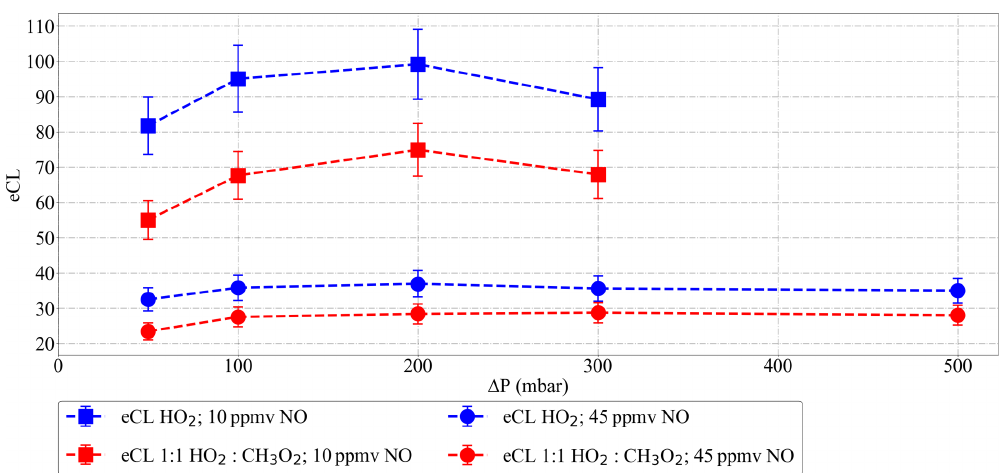
Figure 12. Dependency of eCL on (cid:49)P ( (cid:49)P = P ambient − P inlet ) as determined for PeRCEAS under controlled laboratory conditions for 10ppmv (squares) and 45ppmv (circles) NO at 300mbar inlet pressure. The error bars are 1 σ deviation of eCL values obtained by identical calibrations at each (cid:49)P .